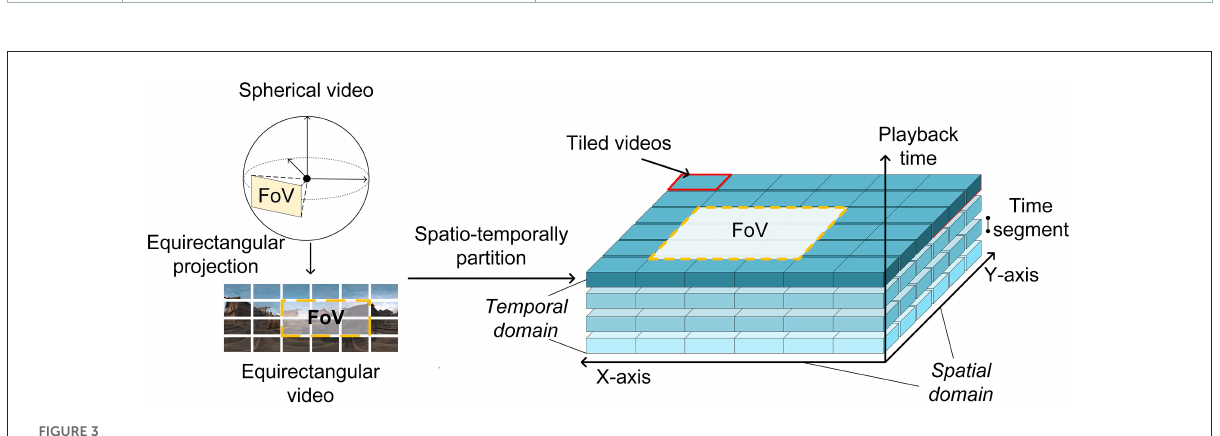
FIGURE3 VR video projection and